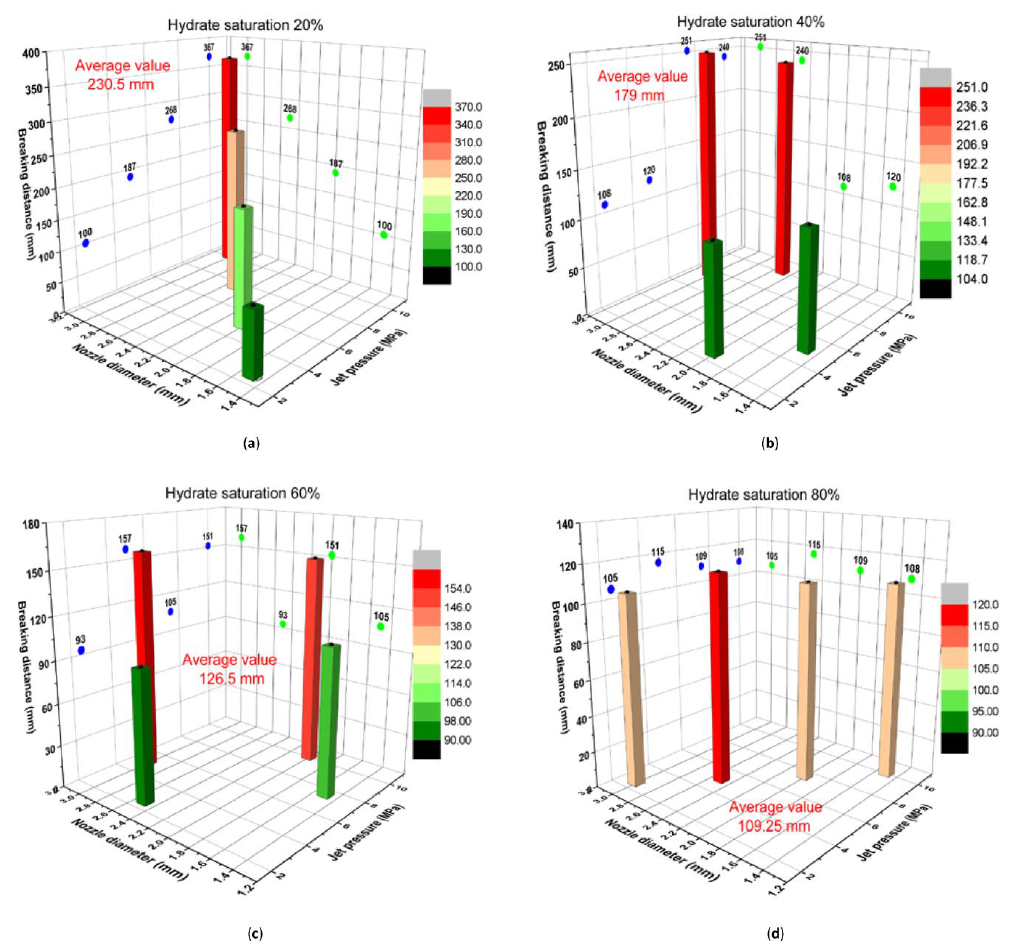
Figure 4. Variation of the breaking distances with nozzle diameter and jet pressure at various NGH saturations: ( a ) NGH saturation is 20%. ( b ) NGH saturation is 40%. ( c ) NGH saturation is 60%. ( d ) NGH saturation is 80%.